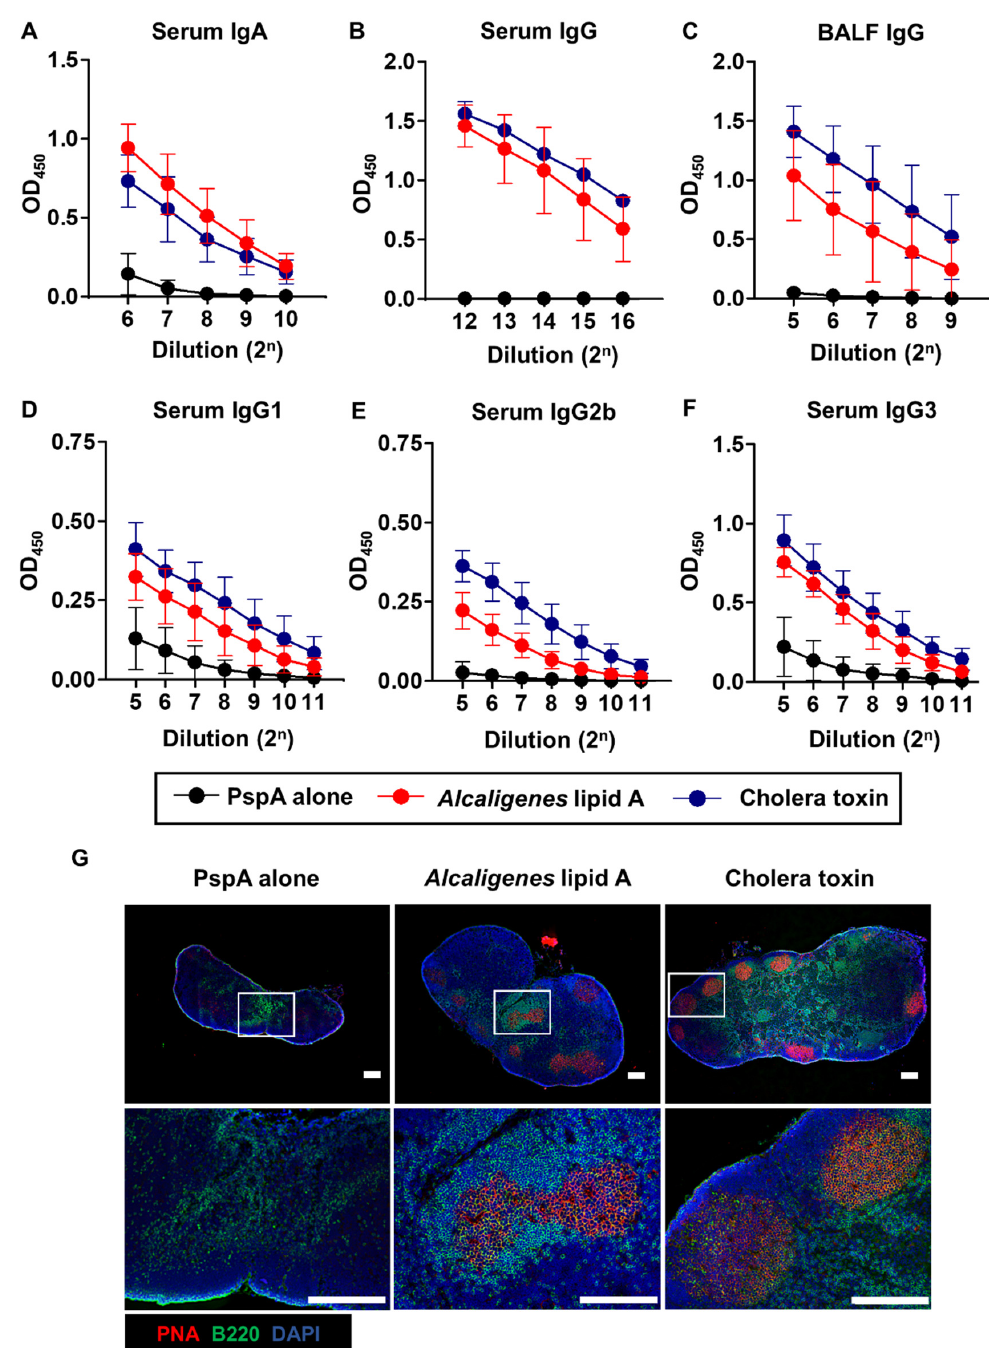
Figure 2. Nasal immunization with PspA, together with Alcaligenes lipid A enhances PspA-specific systemic immune responses. Mice were nasally immunized with PspA with or without Alcaligenes lipid A or cholera toxin three times at one-week intervals. One week after the final immunization, serum and BALF were collected from immunized mice to measure the levels of IgA ( A ) and IgG ( B ) in serum, IgG in BALF ( C ), and IgG subclasses in serum ( D – F ) by using ELISA. Data are representative of two independent experiments and are expressed as means ± SD ( n = 6 per group). OD, optical density. ( G ) Cervical lymph nodes were prepared, stained with the indicated antibodies and reagents, and then observed by using fluorescence microscopy. Bottom panels are magnifications of the rectangles in the corresponding top panels. Scale bars: 200 µm.